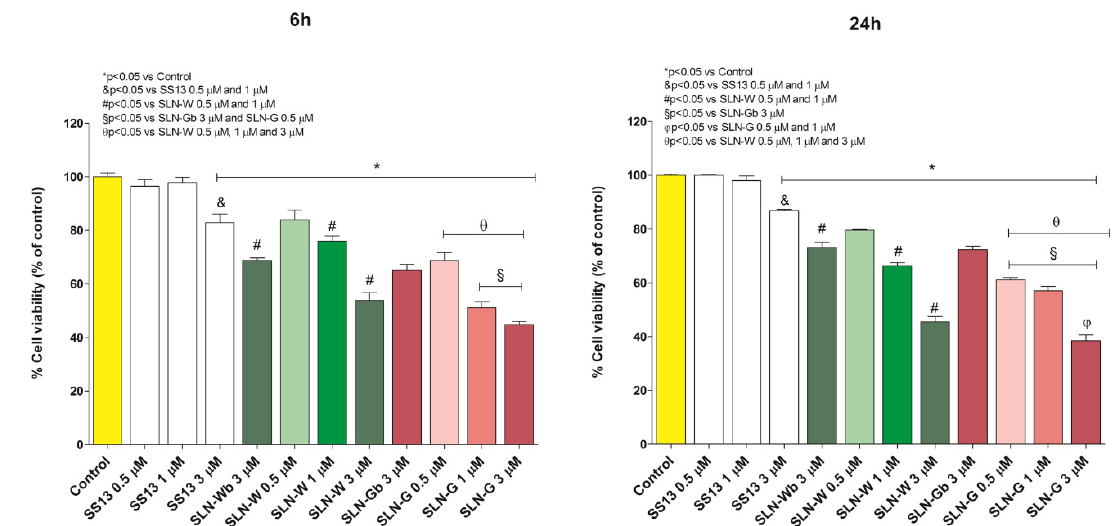
Figure 13. Effect of increasing concentrations (0.5, 1 and 3 µM) of SS13, SLN-Wb, SLN-W, SLN-Gb and SLN-G on CACO-2 cells at 6 and 24 h of exposure. Data are reported as mean ± SD (n = 3). * p < 0.05 vs. Control; & p < 0.05 vs. SS13 0.5 and 1 µM; # p < 0.05 vs. SLN-W 0.5 and µM; § p < 0.05 vs. SLN-Gb 3 µM and SLN-G 0.5 µM; φ p < 0.05 vs. SLN-G 0.5 and 1 µM; ɵ p < 0.05 vs. SLN-W 0.5, 1 and 3